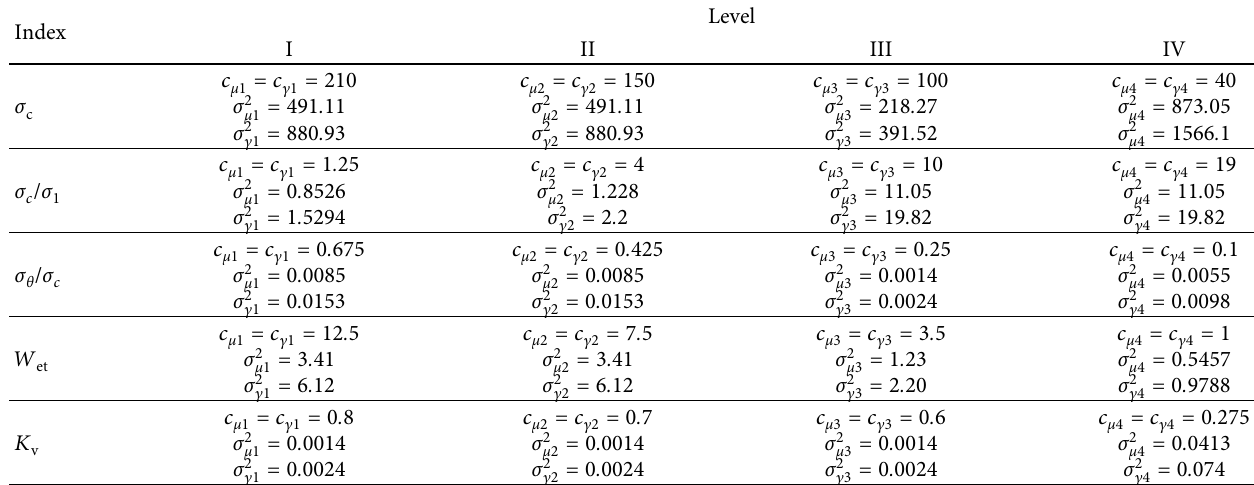
Table 3: Parameters of the membership and non-membership